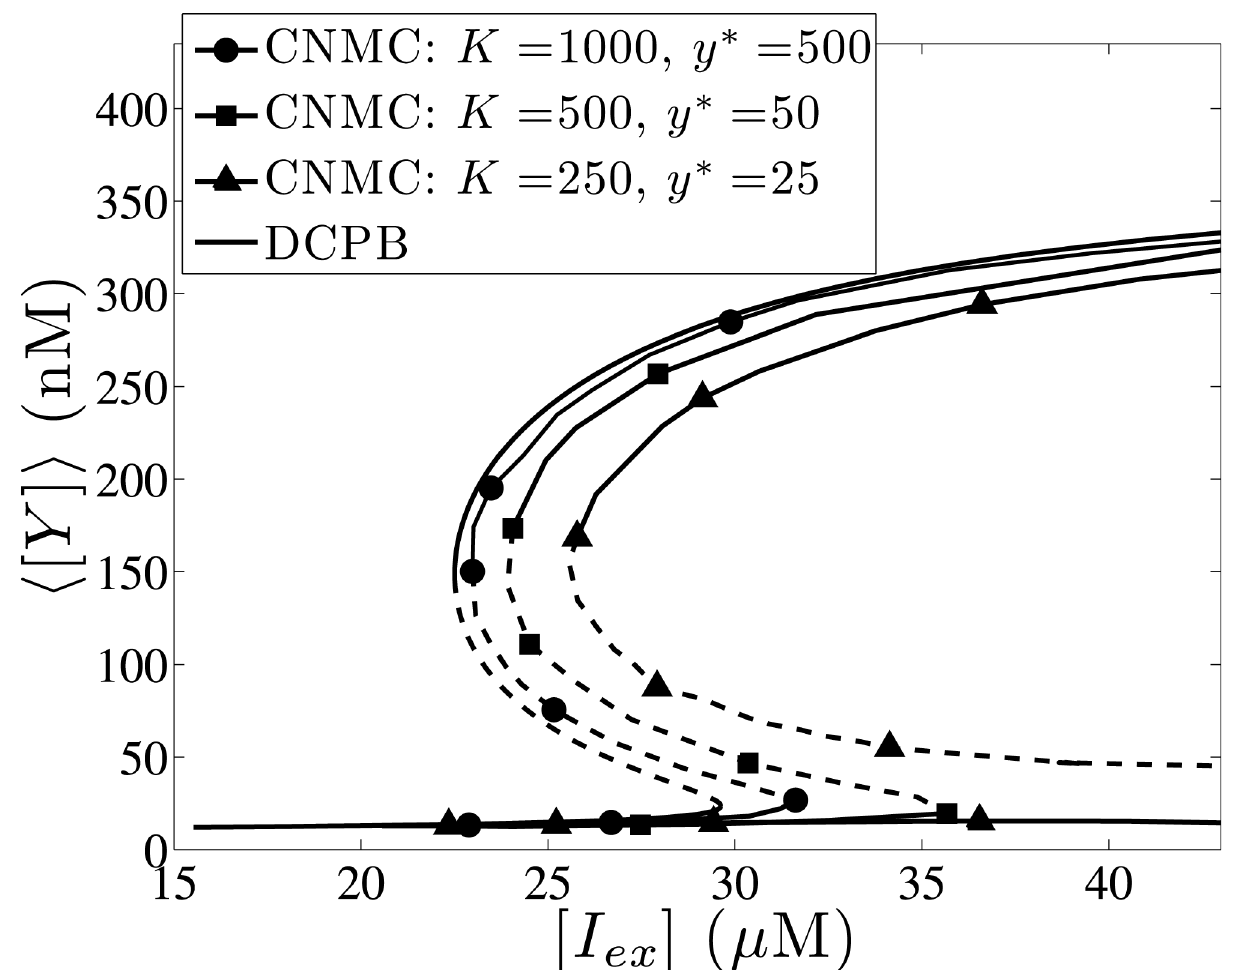
Fig 9. Effect of intrinsic noise intensity. Steady state average expression level, h [ Y ] i , as a function of the external IPTG concentration, [ I ex ], for different K and y * values. The lines with full circles correspond to K = 1000 and y * = 500, the lines with full squares to K = 500 and y * = 50 and the lines with full triangles to K = 250 and y * = 25; the black lines correspond to the DCPB model. Stochastic simulations are performed with N = 10,000 cells (average of 50 copies for noise reduction). Parameter set values: f = 0.5, m = 2, π = 0.03 and κ =